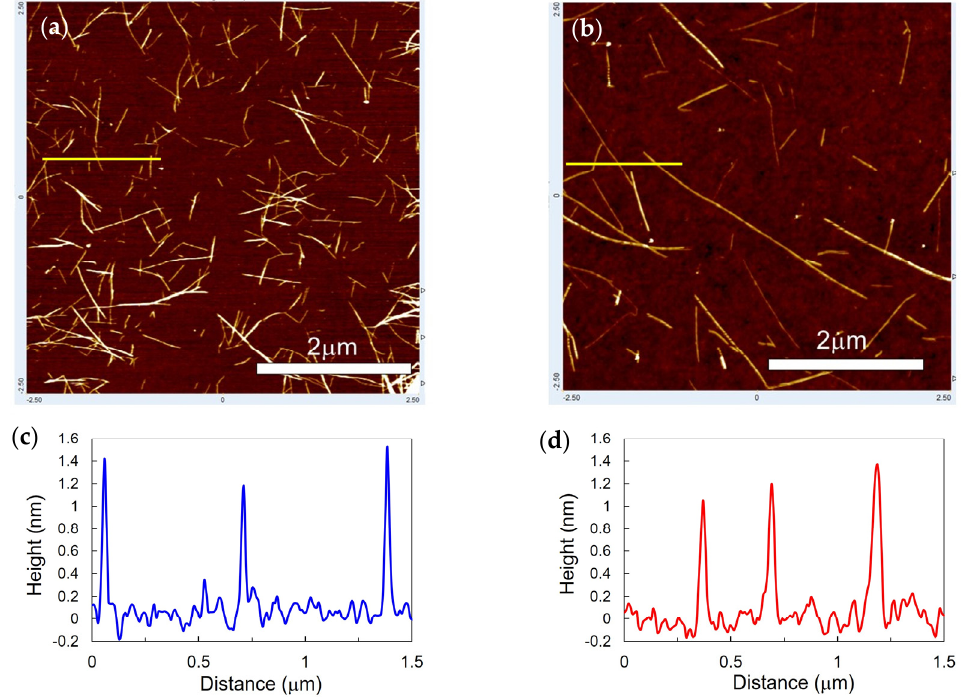
Figure 2. ( a , b ) AFM images SWCNTs on SiO 2 /Si, and ( c , d ) the height profiles for yellow lines specified in the images. SWCNTs were dispersed by using ( a , c ) ultrasonic homogenization and ( b , d ) HCD method.